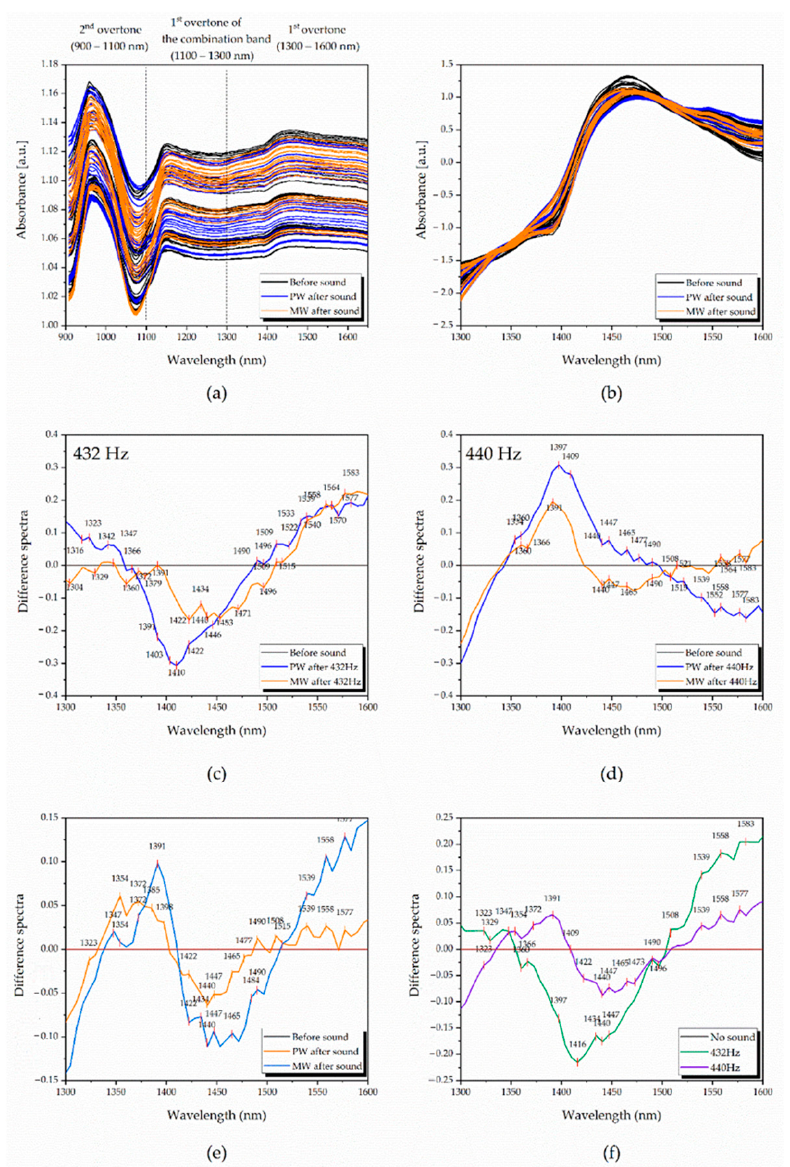
Figure 1. Near-infrared spectra of tested pure and mineral waters and difference spectra analyses (DSA) on defined datasets, preprocessed with SNV: ( a ) Raw spectra, separated into the water overtones; ( b ) raw spectra at the 1st water overtone (1300–1600 nm) transformed with SNV and smoothed with Savitzky–Golay filter using 2nd order polynomial (9 points), showing decreased baseline offset; ( c ) difference spectra analysis of 432 Hz data, with specific spectral patterns for each water; ( d ) difference spectra analysis of 440 Hz data with different spectral patterns than those at 432 Hz; ( e ) difference spectra analysis of averaged water types, displaying similarities in the spectral curves and differences in regions related to small water clusters and water ions; ( f ) difference spectra analysis of averaged frequencies, showing how the gap of 8 Hz can affect water differently.